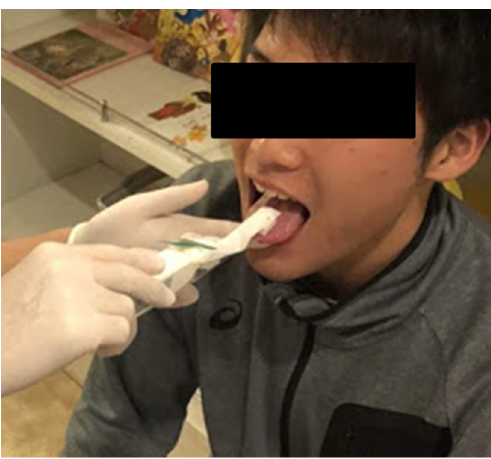
Figure 2. An example of measurement of oral mucosal moisture by using an oral moisture checking device (Mucus ® ; Life Co., Ltd., Saitama, Japan).